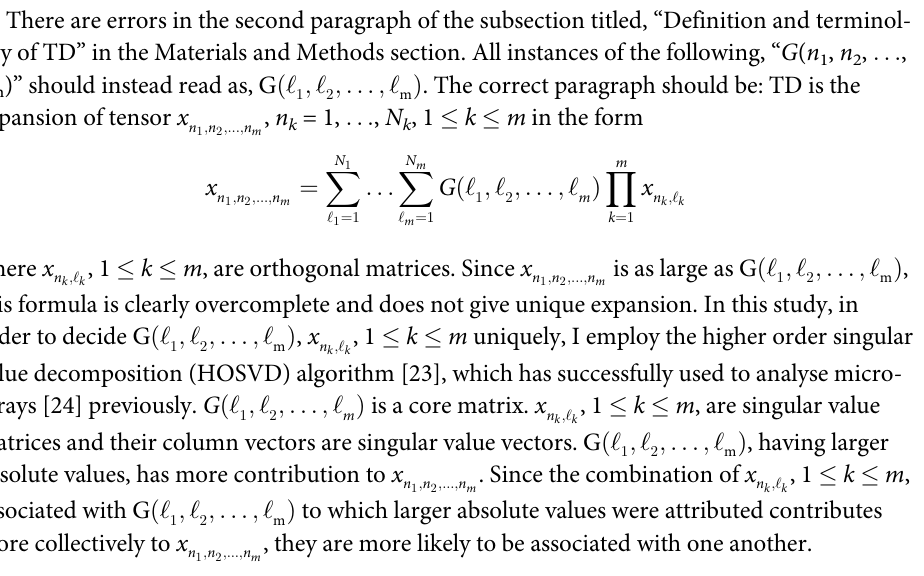
(b), ~ x miRNA (c), 1 (cid:20) ℓ 3 (cid:20) 5, when TD was applied to ‘ 3 ; j ‘ 3 ; j